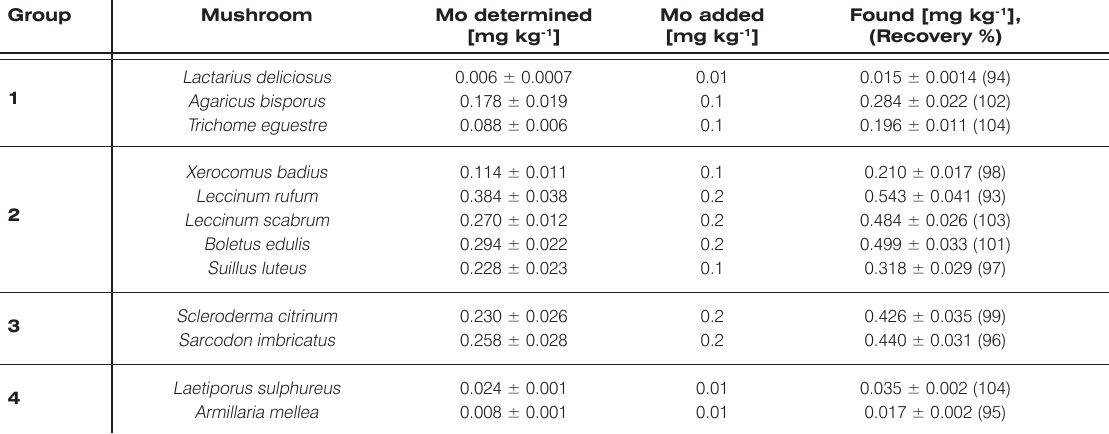
Figure 2. Molybdenum content in investigated mushrooms. Table 1. Results of molybdenum determination in the mushroom